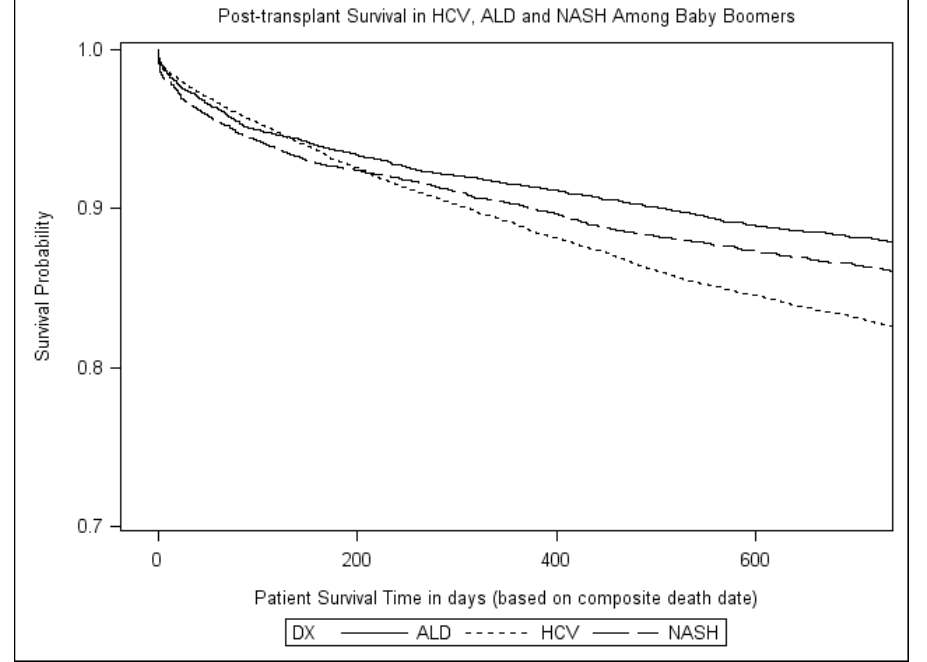
Figure 1. Kaplan–Meier Survival Curves in HCC Post-Liver Transplantation among Baby Boomers with HCV, ALD, and NASH.